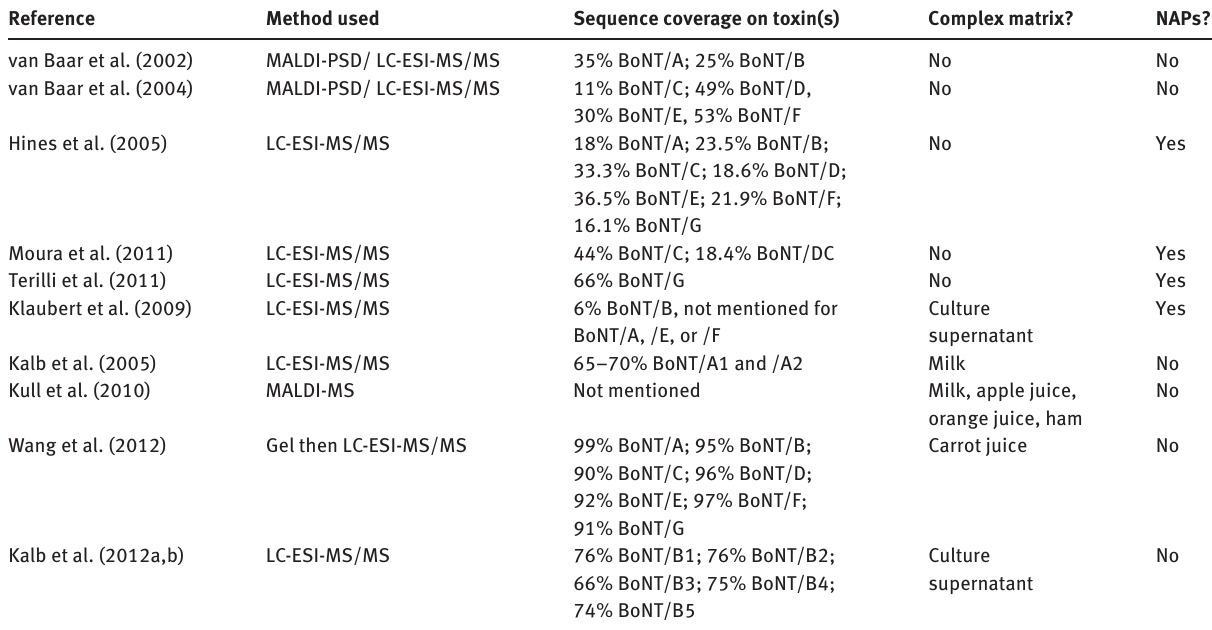
Table 1 Summary of pertinent information from references cited in this